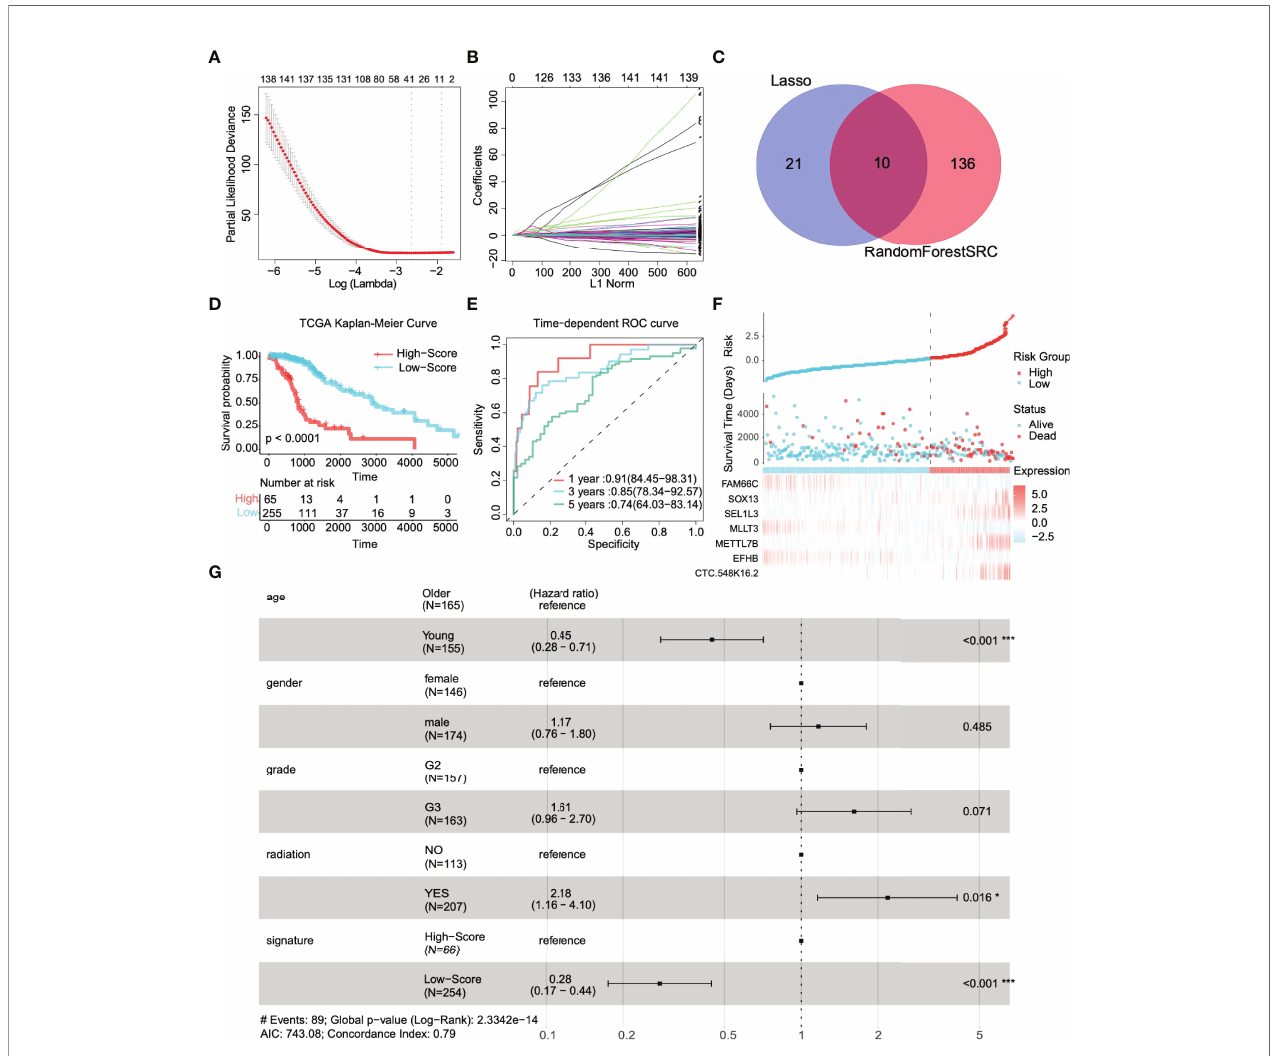
FIGURE 2 | Identi fi cation of prognostic genes and survival prediction of patients with low-grade gliomas in the TCGA training cohort. (A) 100-fold cross-validation for tuning parameter selection in the LASSO model. (B) The distribution of regression coef fi cients of signi fi cantly related genes in the model. (C) Gene selection through two algorithms based on the Venn plot. (D) Kaplan – Meier curves of overall survival (OS) in low-grade glioma are based on the risk score. (E) Time- dependent ROC curve of the risk gene signature at 1, 3, and 5 years in the TCGA training cohort. (F) Distribution of risk score, survival time, and gene expression panel. (G) Subgroup analysis shows the effect of different clinical features in TCGA for OS patients with low-grade glioma. Hazard ratios with 95% con fi dence intervals are shown in each different group. *p < 0.05, ***p < 0.001.